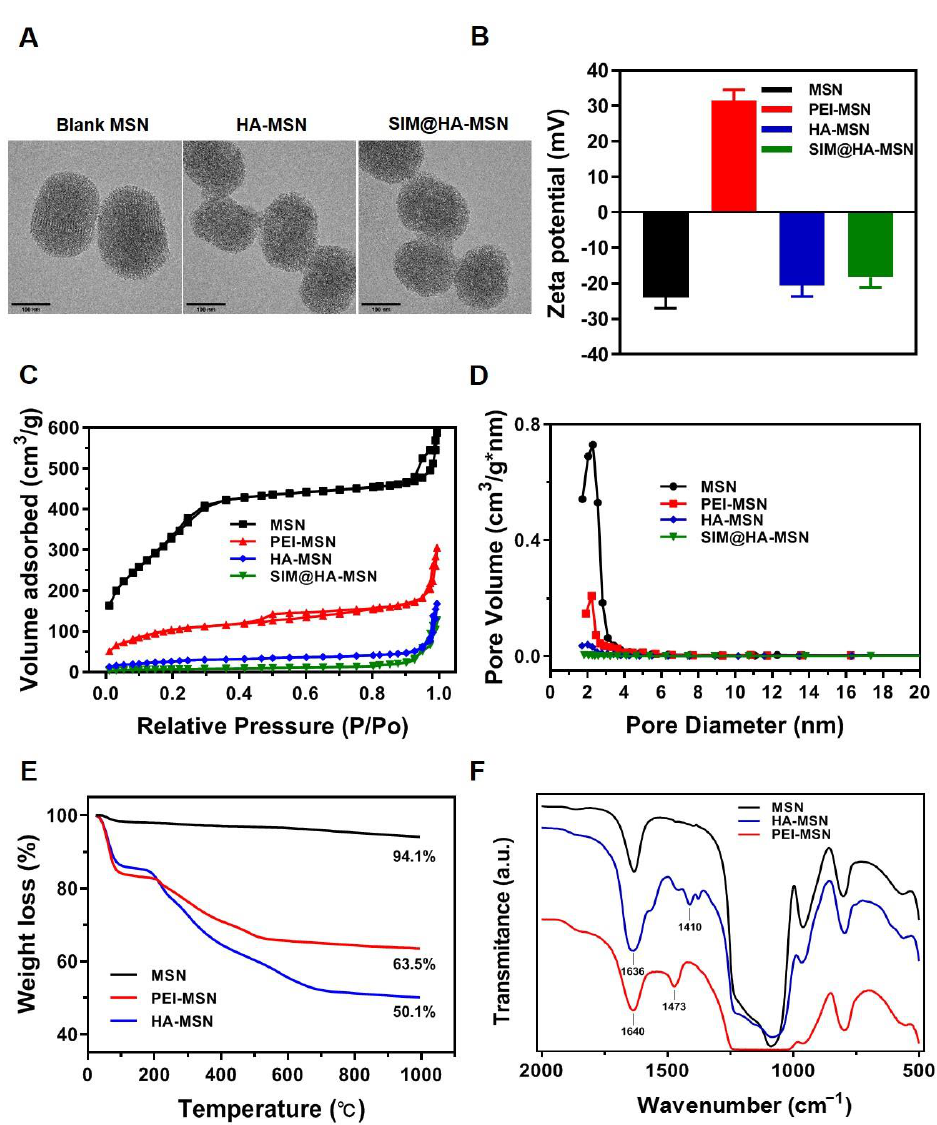
Figure 2. Physicochemical characterizations of MSN-based nanosystems. ( A ) TEM images (scale bar = 100 nm), ( B ) average zeta potentials, ( C ) N 2 adsorption–desorption isotherms, and ( D ) the pore size distributions of bare MSN, PEI-MSN, HA-MSN, and SIM@HA-MSN. ( E ) TGA analysis and ( F ) FT-IR spectra of MSN, PEI-MSN, and